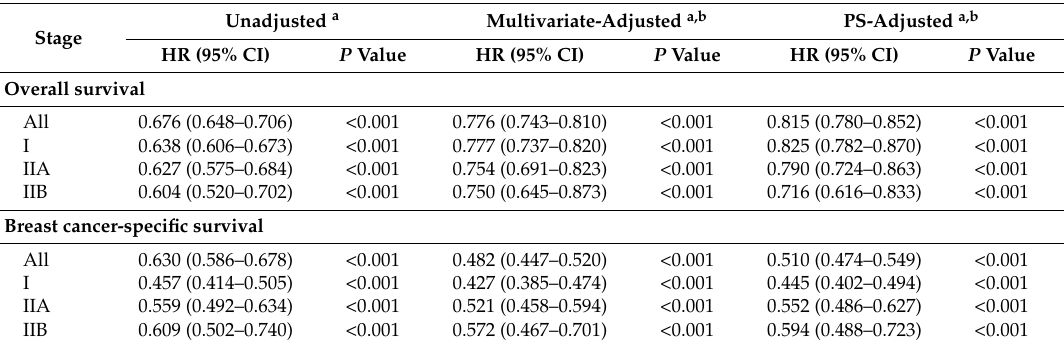
Table 3. Subgroup analysis of overall and breast cancer-specific survival (unilateral vs. contralateral BC) based on stage (I, IIA, and